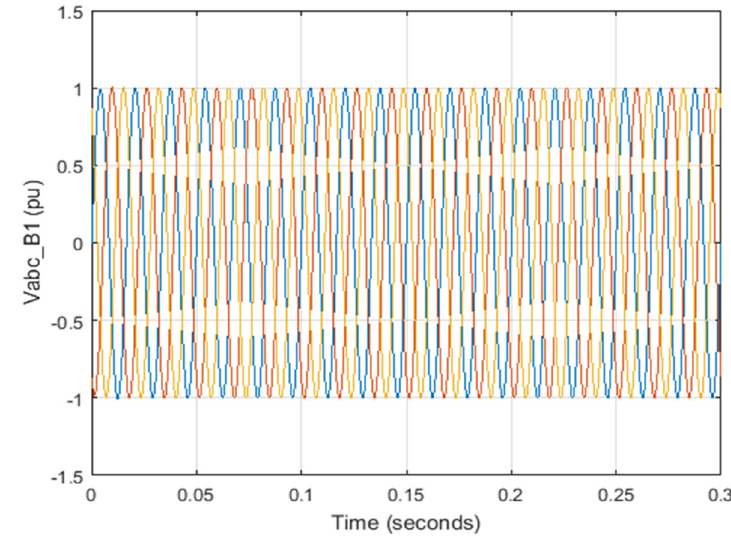
Figure 7. Common point voltage between the grid and microgrid.